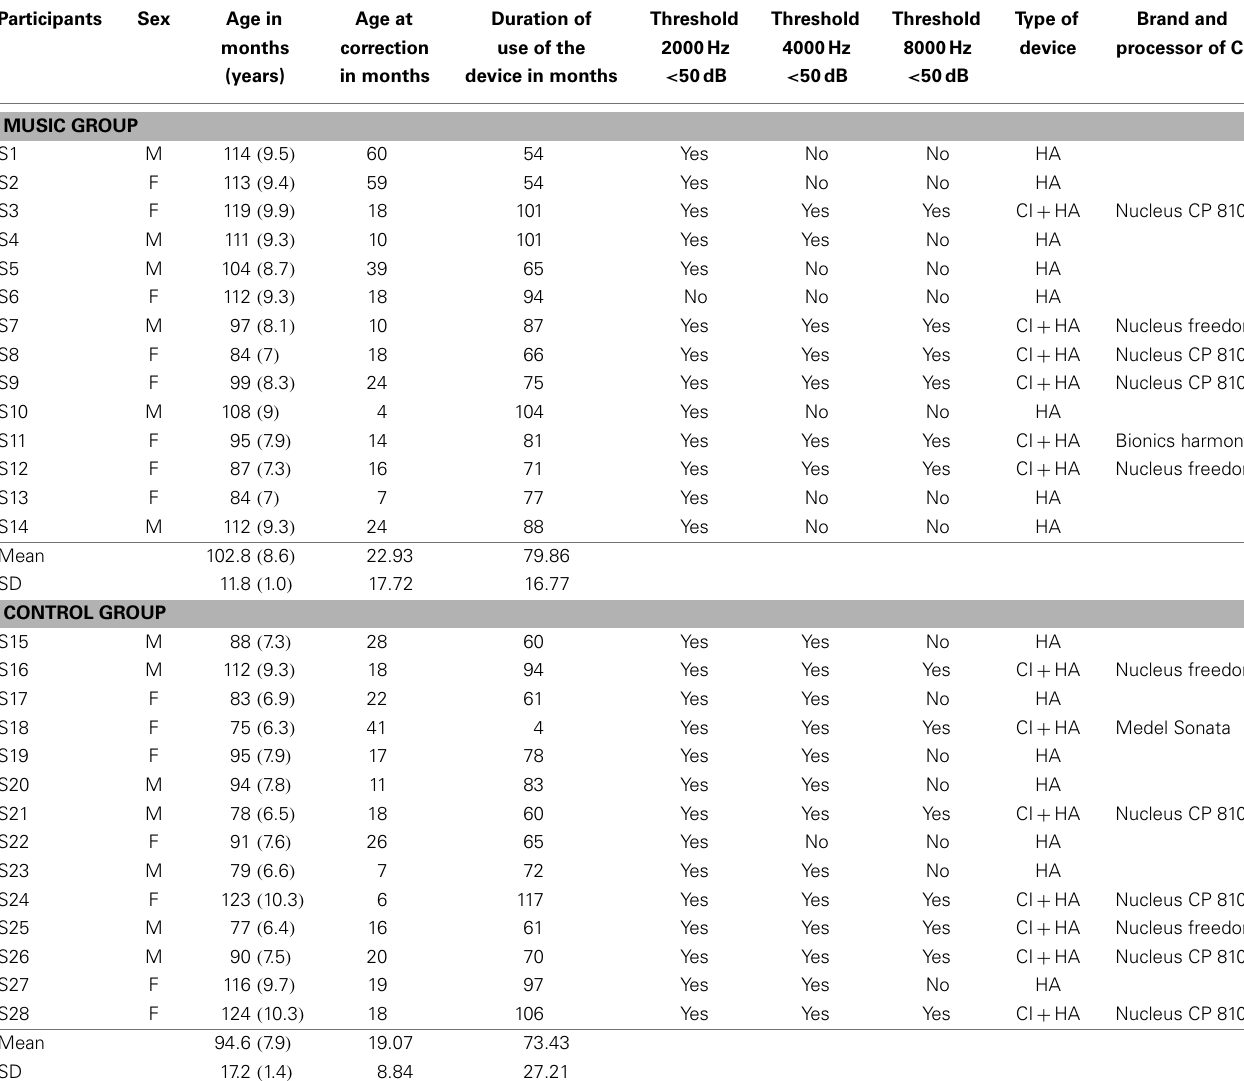
Table 1 | Demographic data of participants (HA, hearing aid; CI, cochlear implant)